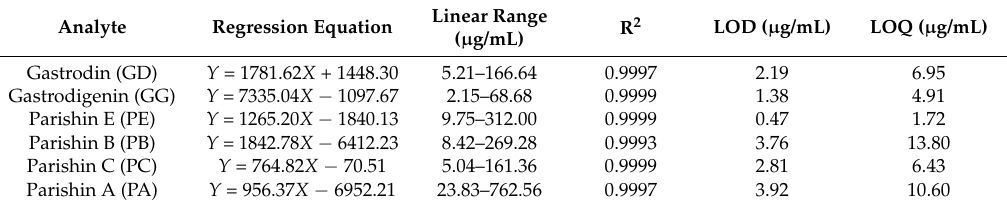
Table 1. The regression equations, LODs and LOQs of six gastrodin-type components.